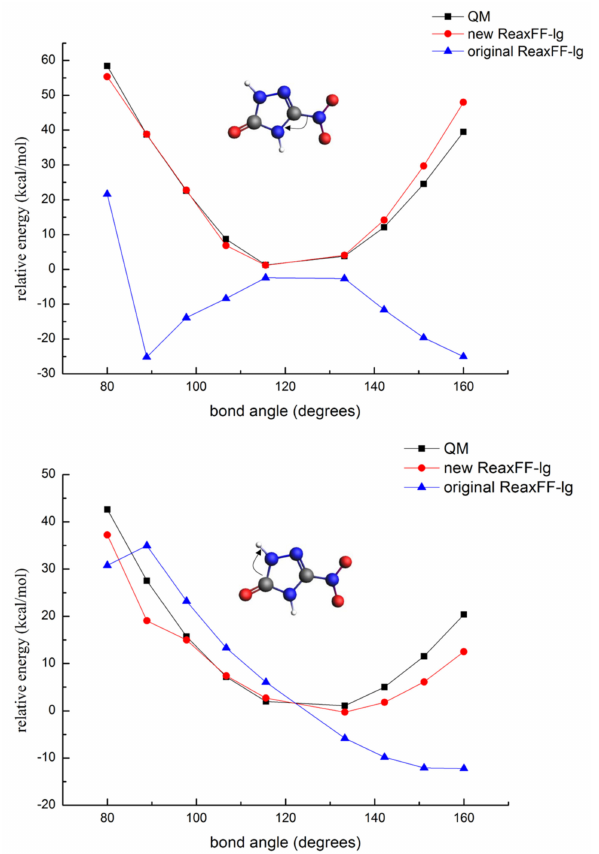
Figure 5. Energy barriers for the distortion of the N-C-N and C-N-H bond angles in NTO (gray— carbon atom; white—hydrogen atom; red—oxygen atom; blue—nitrogen